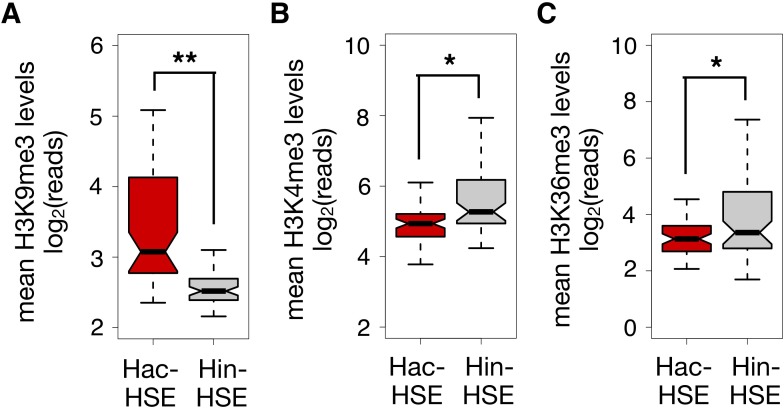
HSR genes with adjacent Hac- or Hin-HSEs display different levels of histone modifications associated with gene expression or repression.(A) Notched boxplot showing distributions of H3K9me3 ChIP-seq reads using publicly available data obtained from L3 stage worms during NHS conditions (Ho et al., 2014) over Hac- or Hin-HSE HSR gene bodies. H3K9me3 data were obtained from the modMine database (intermine.modencode.org) (Contrino et al., 2012) under accession number modEncode_5040. (B) Notched boxplot showing distributions of H3K4me3 ChIP-seq reads using publicly available data obtained from L3 stage worms during NHS conditions (Ho et al., 2014) over Hac- or Hin-HSE HSR gene 5’ regions (1 kb windows centered on annotated transcriptional start sites). H3K4me3 data were obtained from the modMine database under accession number modEncode_3576. (C) Notched boxplot showing distributions of H3K36me3 ChIP-seq reads using publicly available data obtained from L3 stage worms during NHS conditions (Ho et al., 2014) over Hac- or Hin-HSE HSR gene bodies. H3K36me3 data were obtained from the modMine database under accession number modEncode_3563. For panels A-C, a single asterisk represents p<0.01, and double asterisks represent p<1.0e-06 (Welch Two Sample t-test).